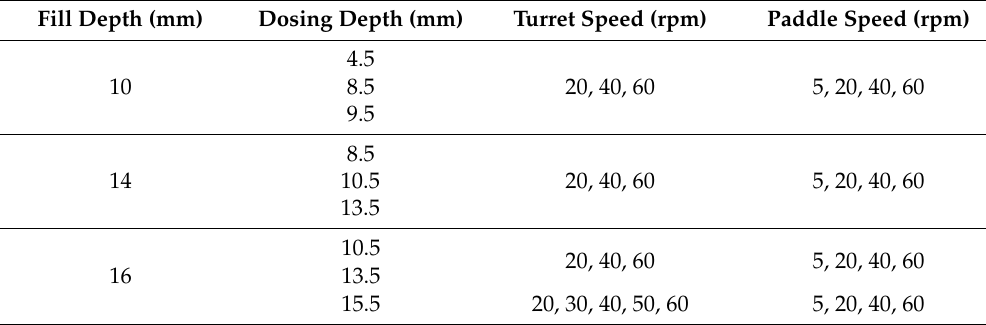
Table 3. Process parameters for tablet production with XL 100.